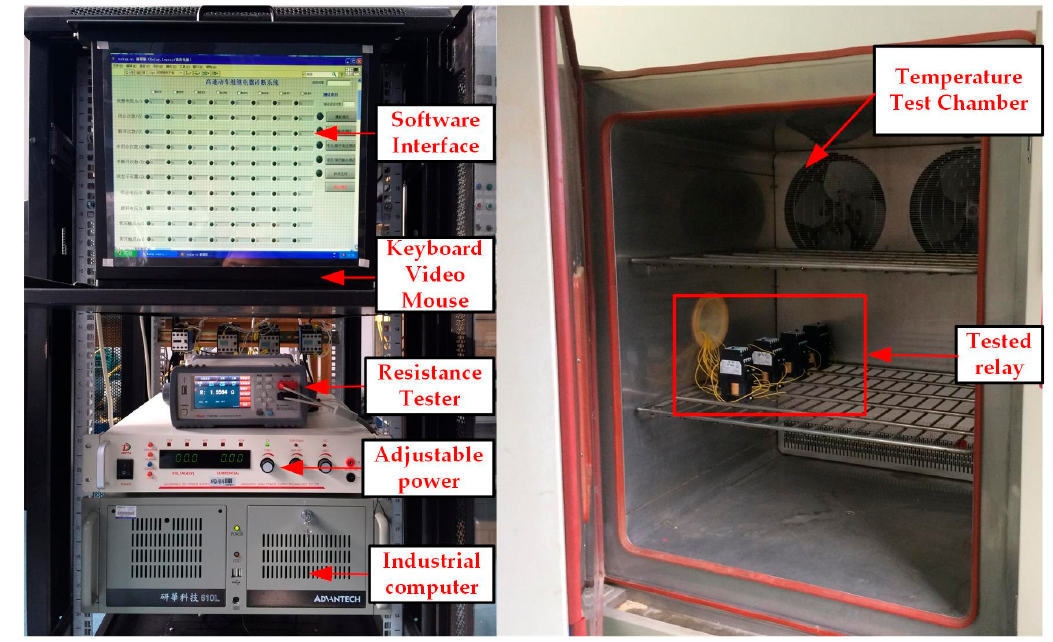
Figure 4. Test platform.